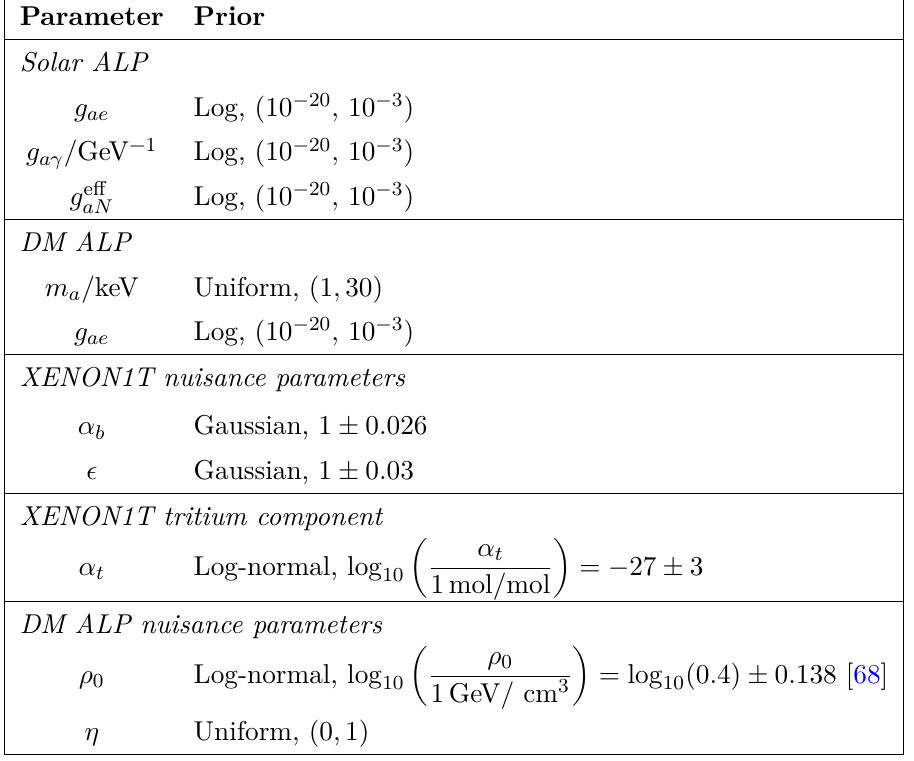
Table 5. Choices of prior for the solar and DM ALP models and nuisance parameters. We discuss these choices at the beginning of section